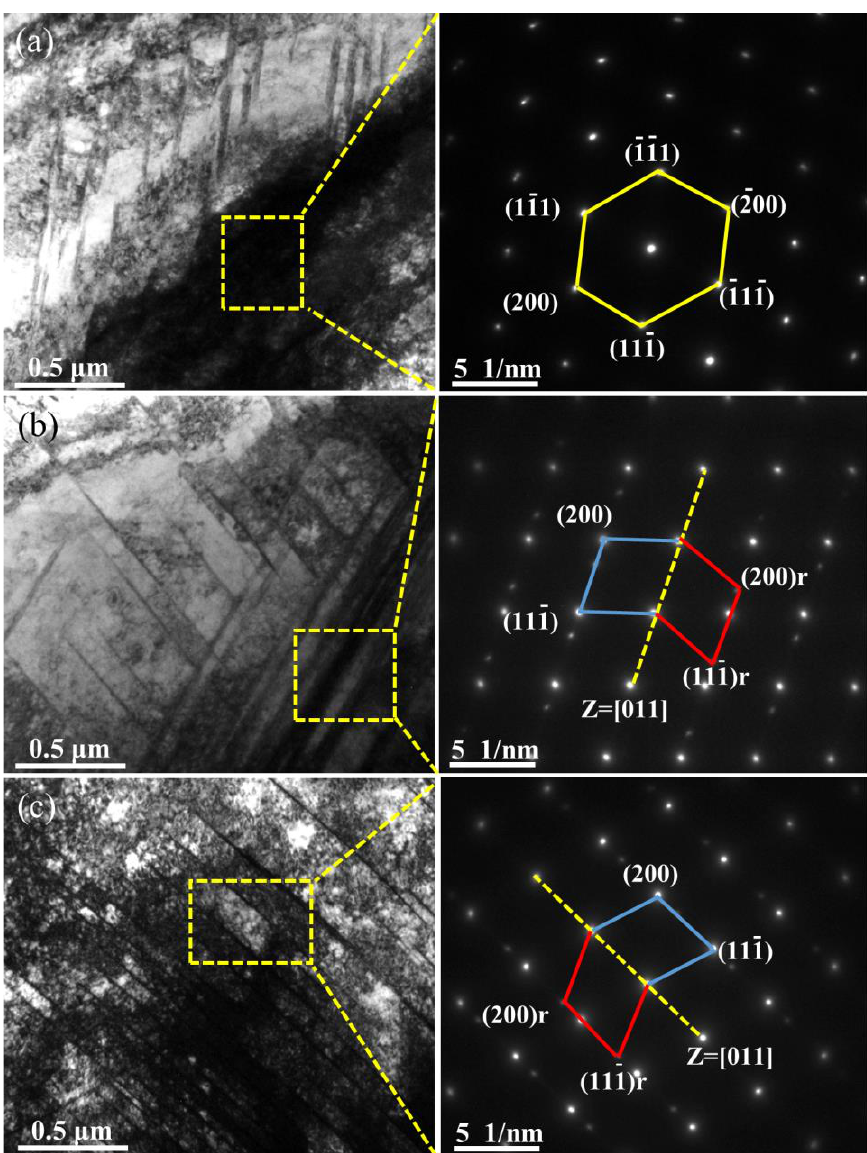
Figure 7. The TEM bright-field images and selected electron diffraction of alloys at 10% tensile strain: ( a ) VS; ( b ) PS; ( c ) PS0.5.